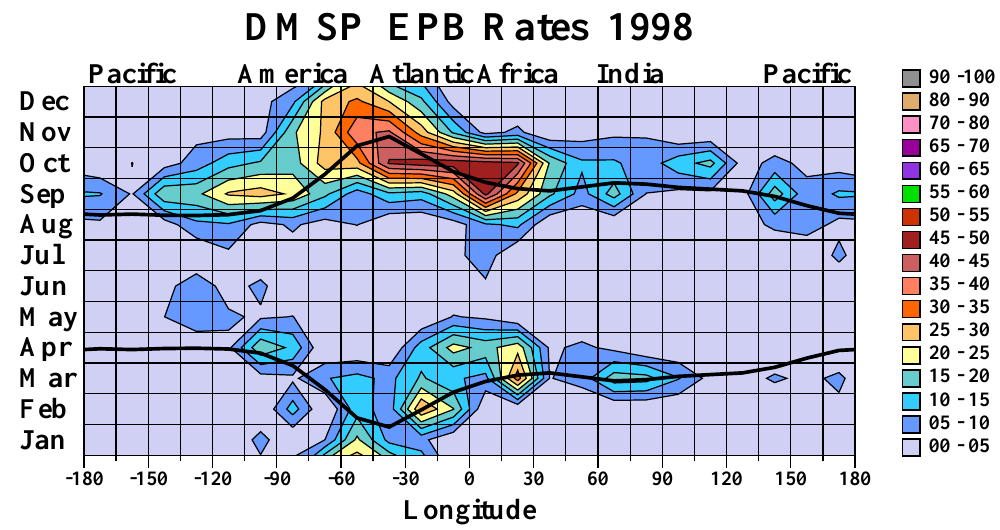
Fig. 8. For transition year 1998, highest EPB rates (45%–50%) occurred in the Atlantic-Africa sector late in the